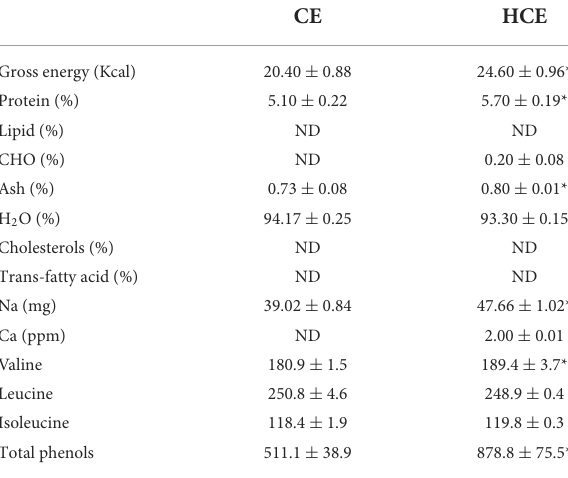
TABLE 1 Contents of nutritional components and total phenols in different types of chicken